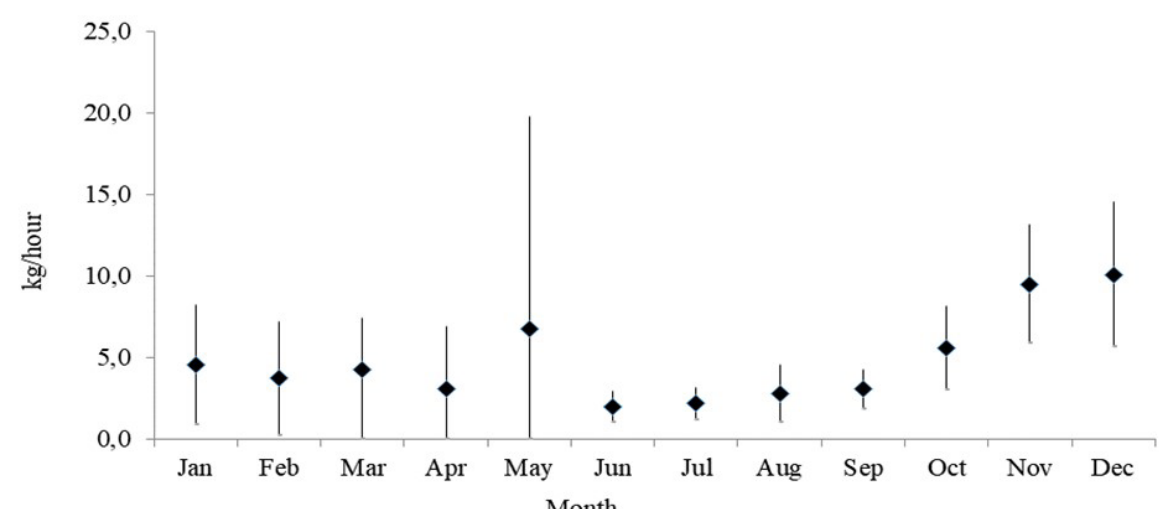
Figure 7. Monthly catch per unit effort (kg * h -1 ) (bars is standard deviation) of catfish ( Genidens barbus ), in the artisanal fisheries, derived from landings on the south coast of São Paulo (Cananeia, Iguape and Ilha Comprida city), during the period 2000 to 2014, with use bottom gillnets.